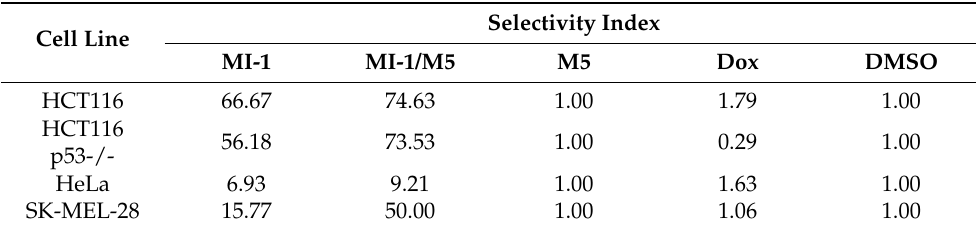
Table 2. The selectivity index (SI) of the studied compounds towards human tumor cells of differ- ent